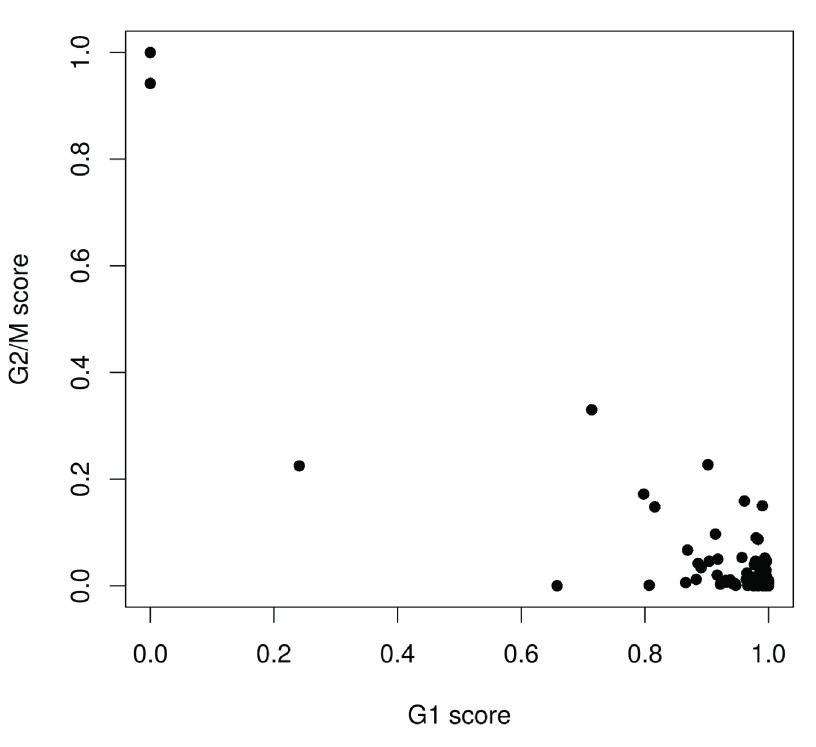
Cell cycle phase scores from applying the pair-based classifier on the HSC dataset, where each point represents a cell.